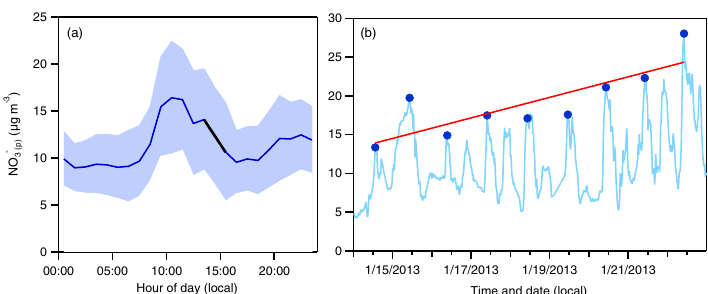
Figure 6. (a) Average diurnal profile (solid line) of surface NO − deviation. The solid black line is a linear fit ( r 2 = 0 . 99) to the data between 13:30 and 15:30LT. (b) Time series (solid blue line) of surface- level NO − during Episode 1. The circles indicate the daytime peak values. The linear fit (red line) to the daytime NO − 3 ( p ) an increase of 1.32µgm − 3 day − 1